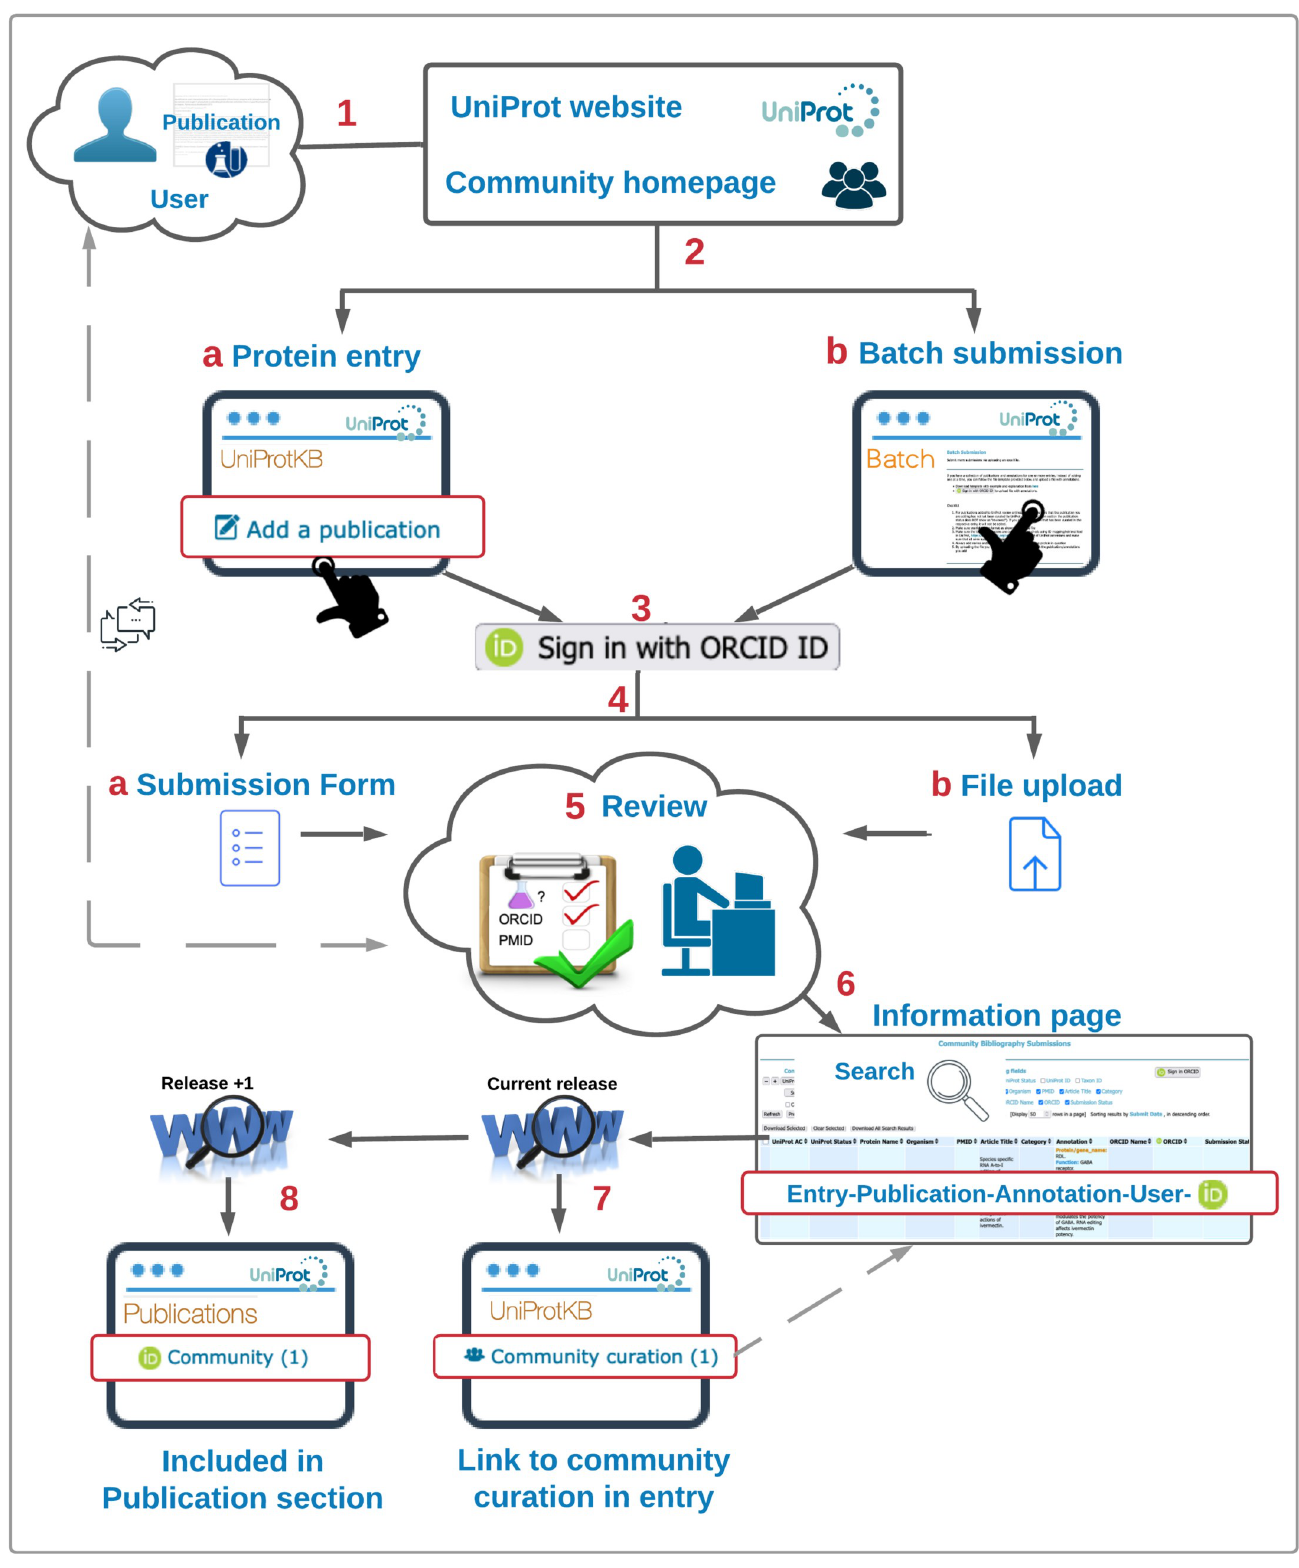
Fig 1. Overview of the submission process.